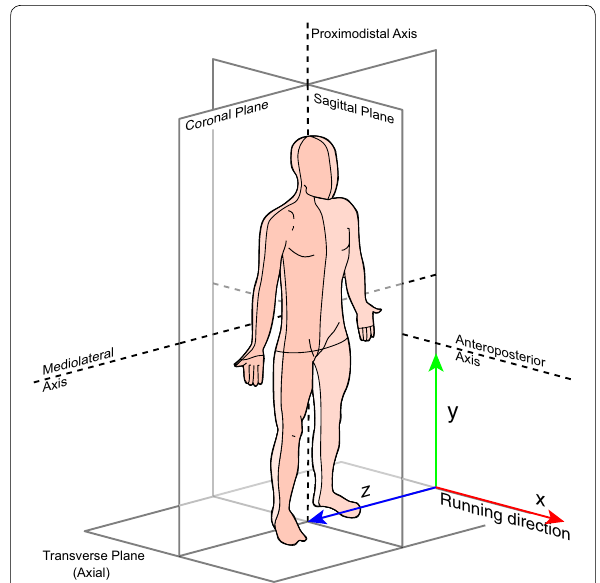
Fig. 3 Planes and axes around a runner and a running environment.